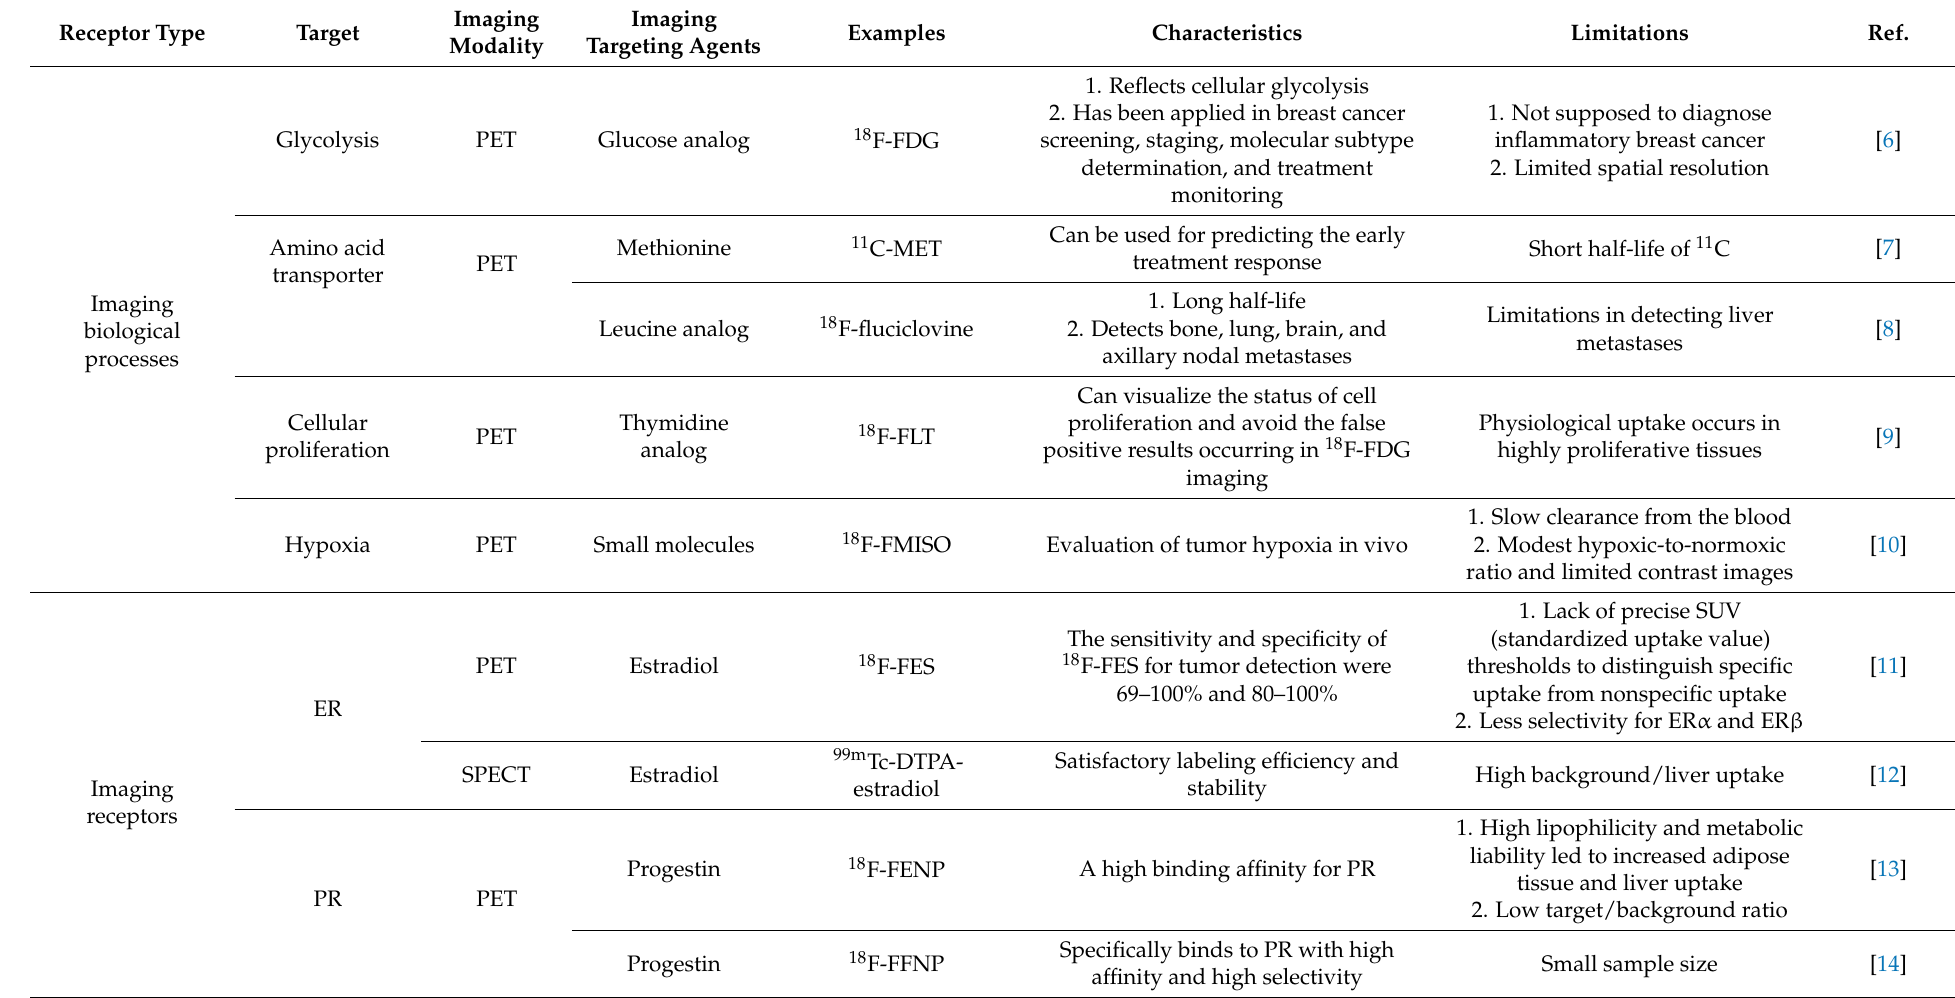
Table 1. Summary of various radiotracers for breast cancer